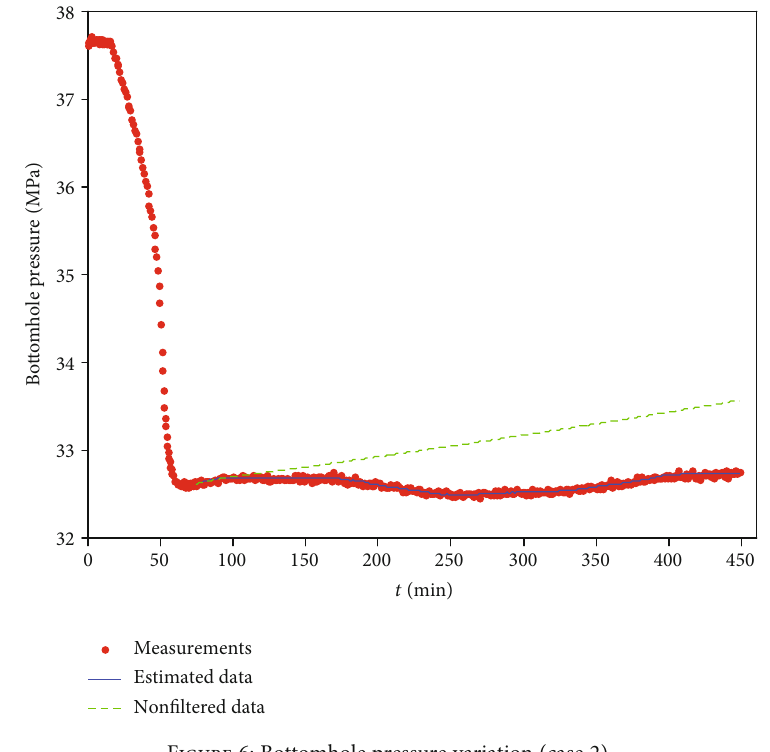
Figure 6: Bottomhole pressure variation (case 2).